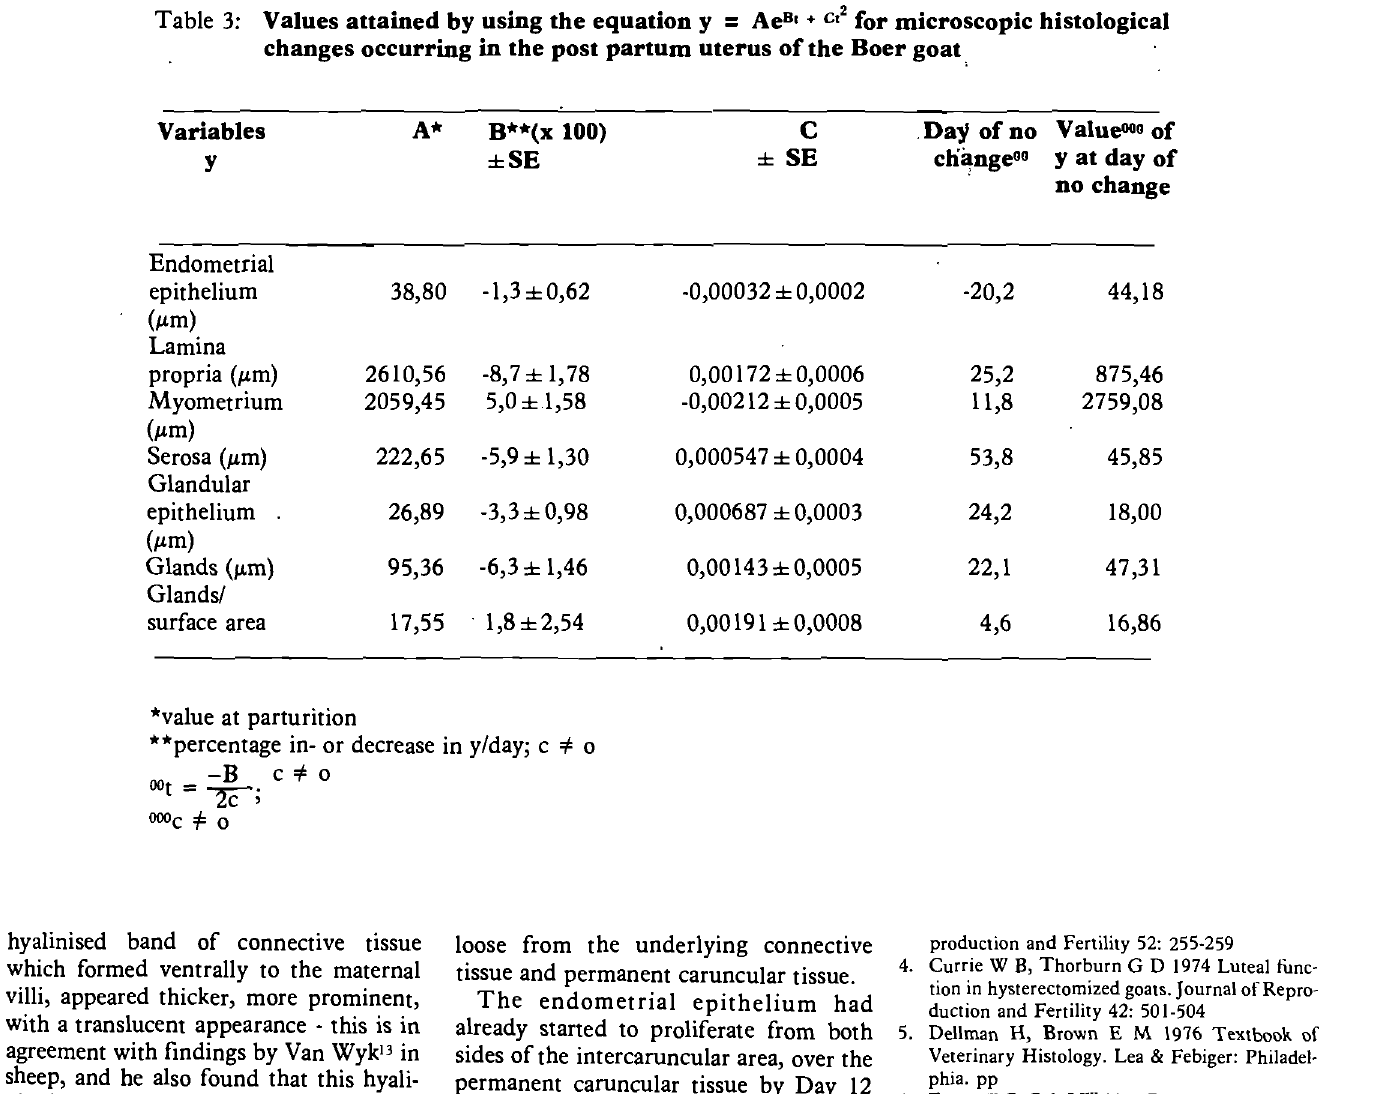
= Ae B1 + cI2 for microscopic histological .Day of no ValueOO o